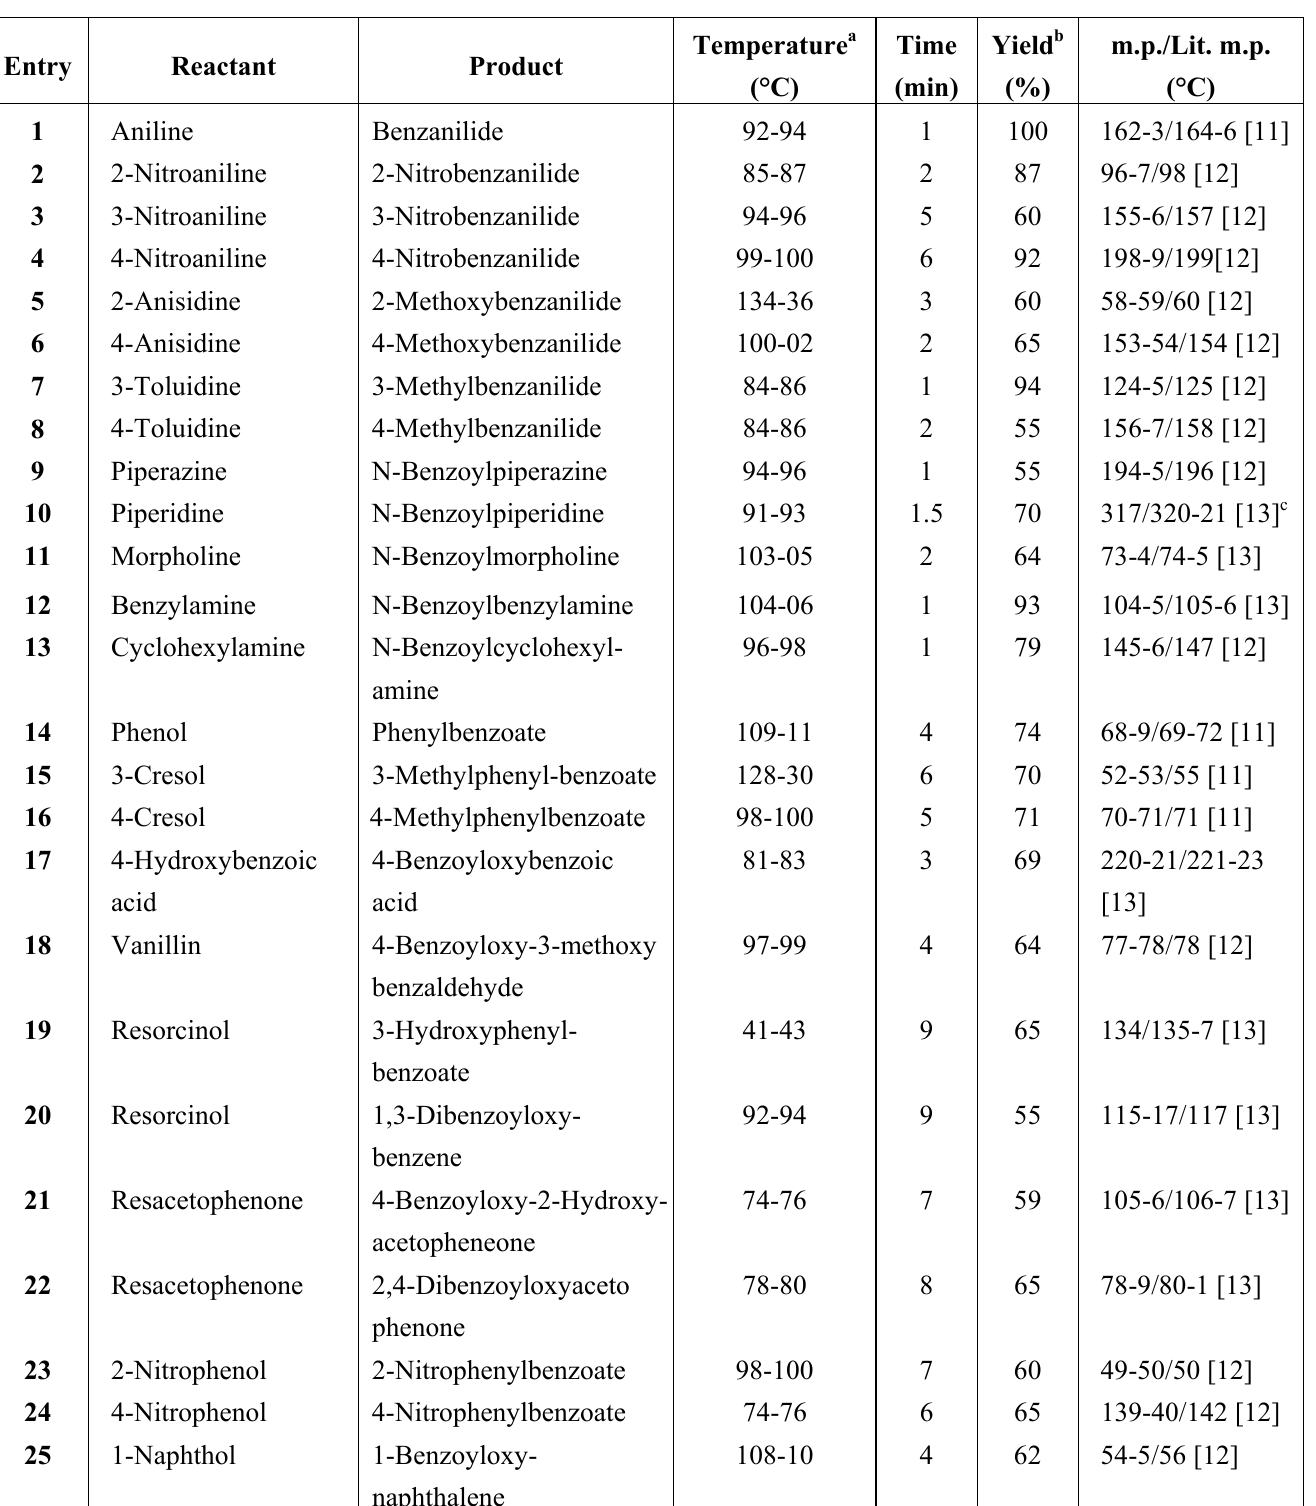
Table 2. Microwave-assisted N-, O- and S-benzoylations using PhCOCl-Py/basic alumina (power =